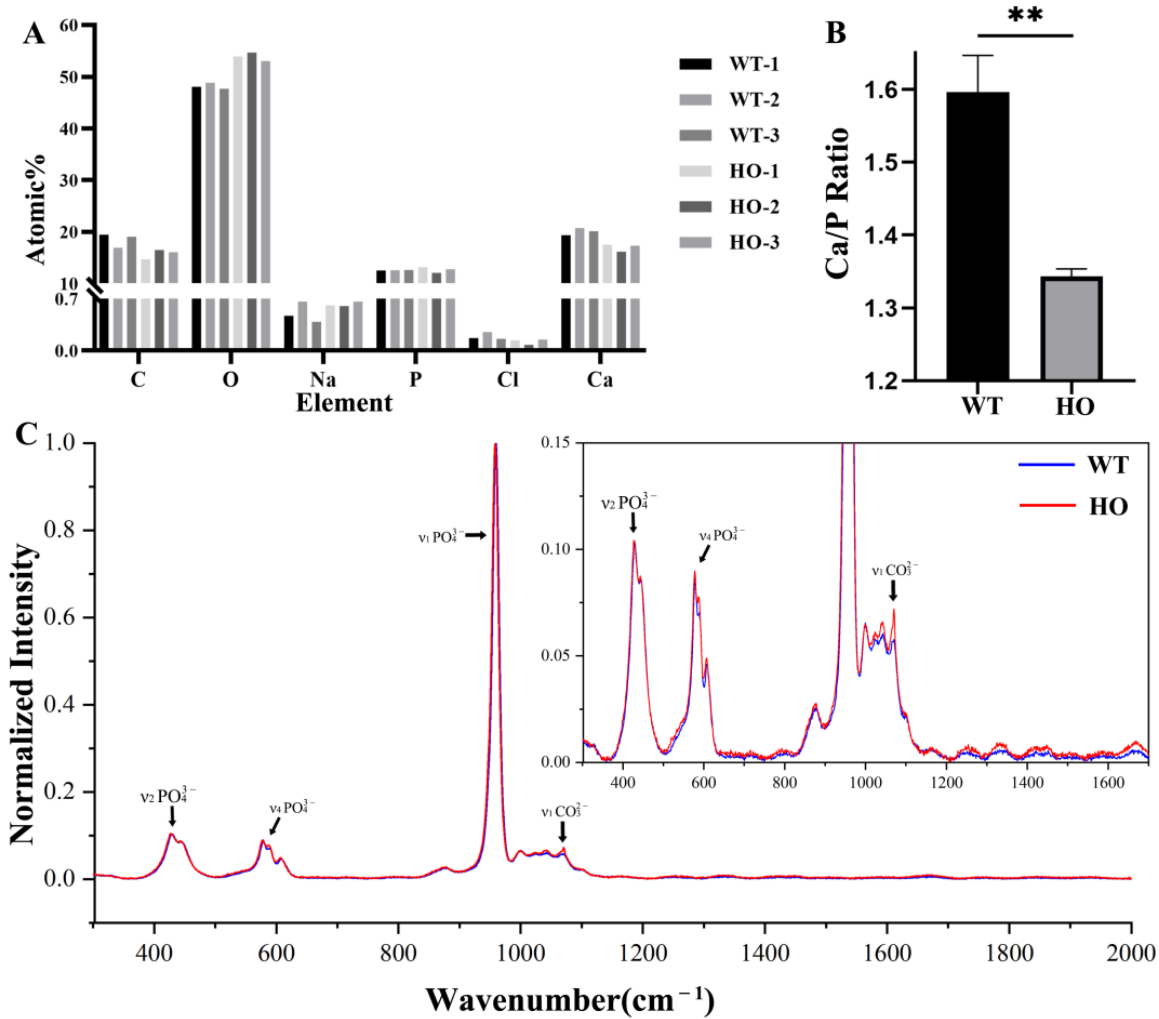
Figure 6. Enamel mineral composition and crystal properties: ( A ) Element analysis data of the WT and HO mice enamel by atom% from EDX. ( B ) The average Ca/P ratio of enamel samples in HO mice was significantly lower than that in WT mice: ** p < 0.01. Error bars denote mean ± SD. ( C ) Overlapping normalized spectra of WT mice enamel (blue) and HO mice enamel (red). In the test, the position of the bands was nearly the same in the WT and HO mice enamel as reported previously (Figure 6C), demonstrating that the major mineral con- stituents did not vary strongly between the WT and HO samples. However, relative to the main phosphate vibration at 959 cm − 1 , several changes could be observed in the HO mice enamel, for example, the ν 1 CO 3 2 − , because of the type-B carbonate substitution in the apatite lattice in the defective enamel. The ν 1 PO 43 − band associated with the P-O stretch shifted a little from 959.35 ± 0.10 cm − 1 in the WT samples, and to 959.02 ± 0.10 cm − 1 in the HO samples (Table 2). The FWHM of the ν 1 PO 43 − band was found to be wider in the HO samples (15.11 ± 0.27 cm − 1 ) than in the WT samples (13.83 ± 0.14 cm − 1 ) ( p < 0.001).